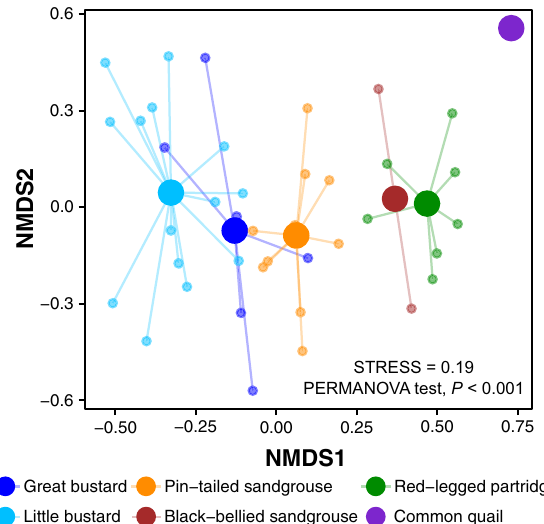
sandgrousePin−tailed sandgrouseGreat bustard Black−bellied Little bustard Figure 1. Graphical illustration of the results of the NMDS analysis of the studied birds’ diet (OTUs). Larger dots represent the centroid of the flocks of each species, while smaller dots represent the individual flock data of each